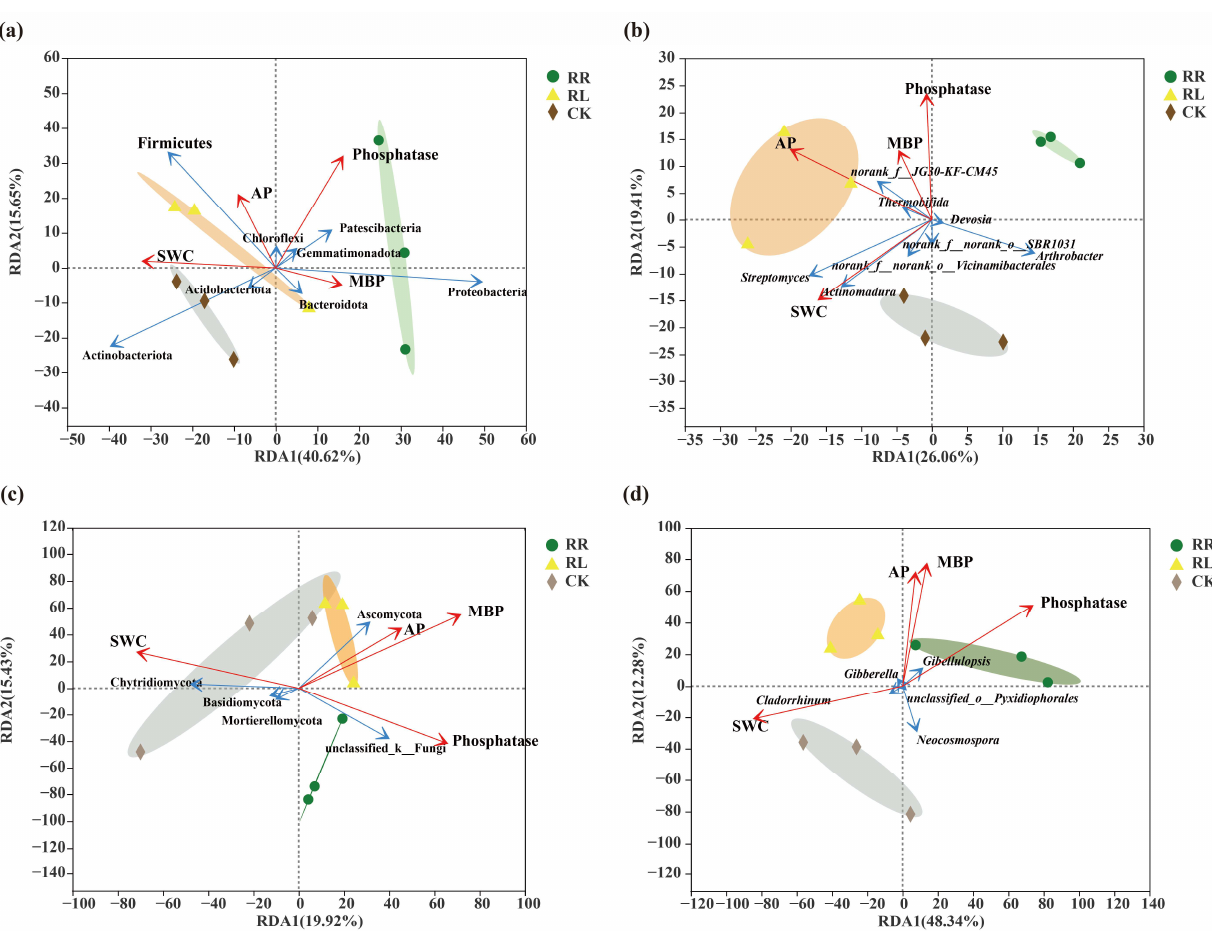
Figure 7. Redundancy analysis (RDA) of oilseed rape in the monoculture (RR), intercropping system (RL) and CK. SWC, soil water content; MBP, microbial biomass phosphorus; AP, available phosphorus. ( a ) Soil bacteria at the phylum level. ( b ) Soil bacteria at the genus level. ( c ) Soil fungi at the phylum level. ( d ) Soil fungi at the genus level.